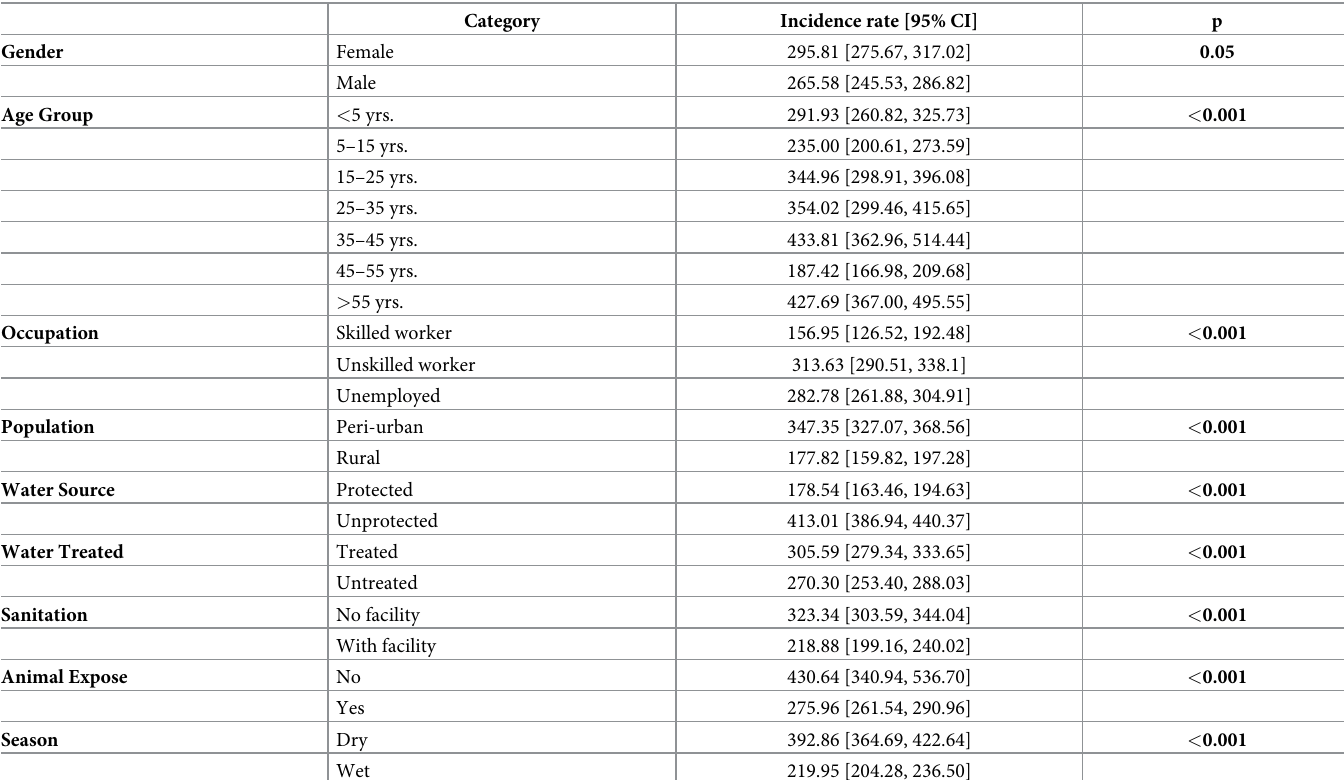
Table 3. Diarrhea case incidence rates by category (per 1000 per